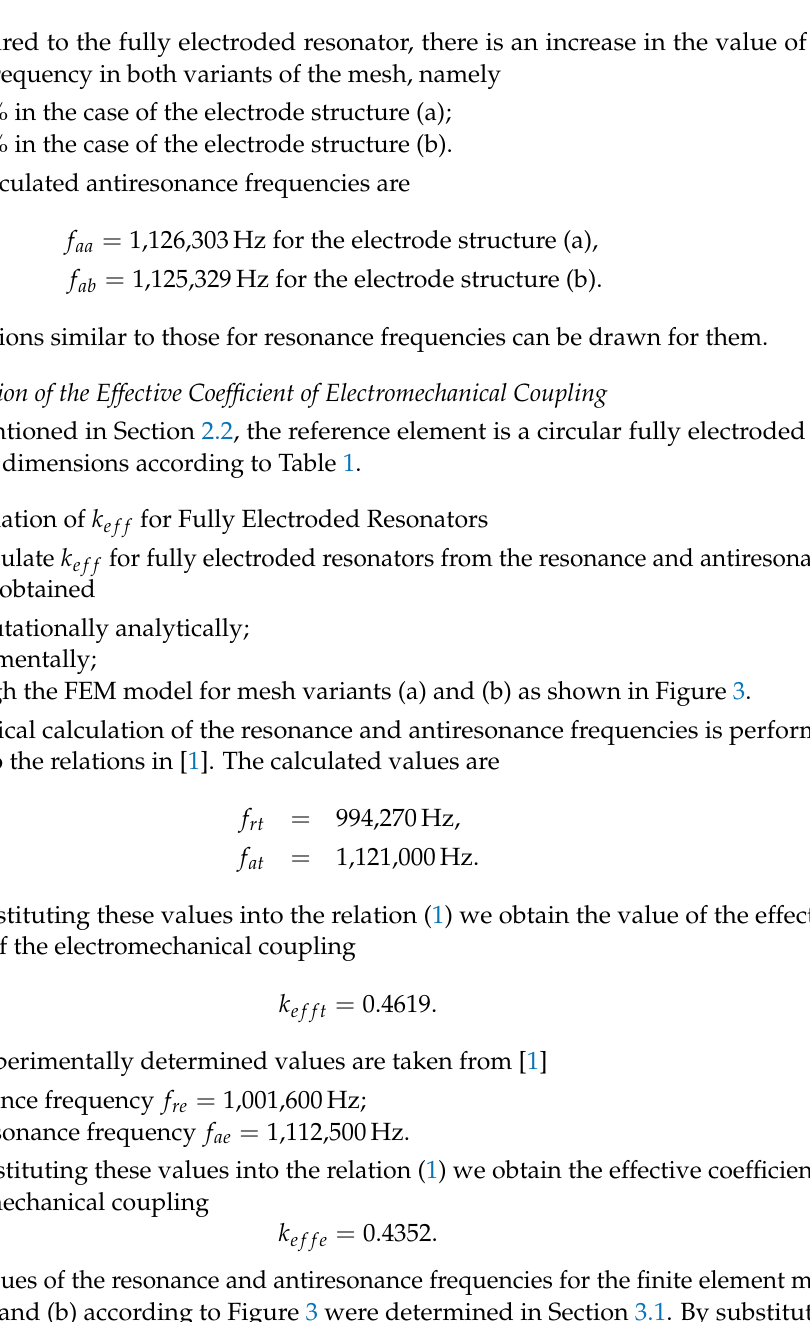
Figure 5. Shape of the oscillation in the electrode symmetry plane, for the electrode structure (a). The calculated resonance frequencies are f ra = 1,006,413 Hz for the electrode structure (a), f rb = 1,004,792 Hz for the electrode structure